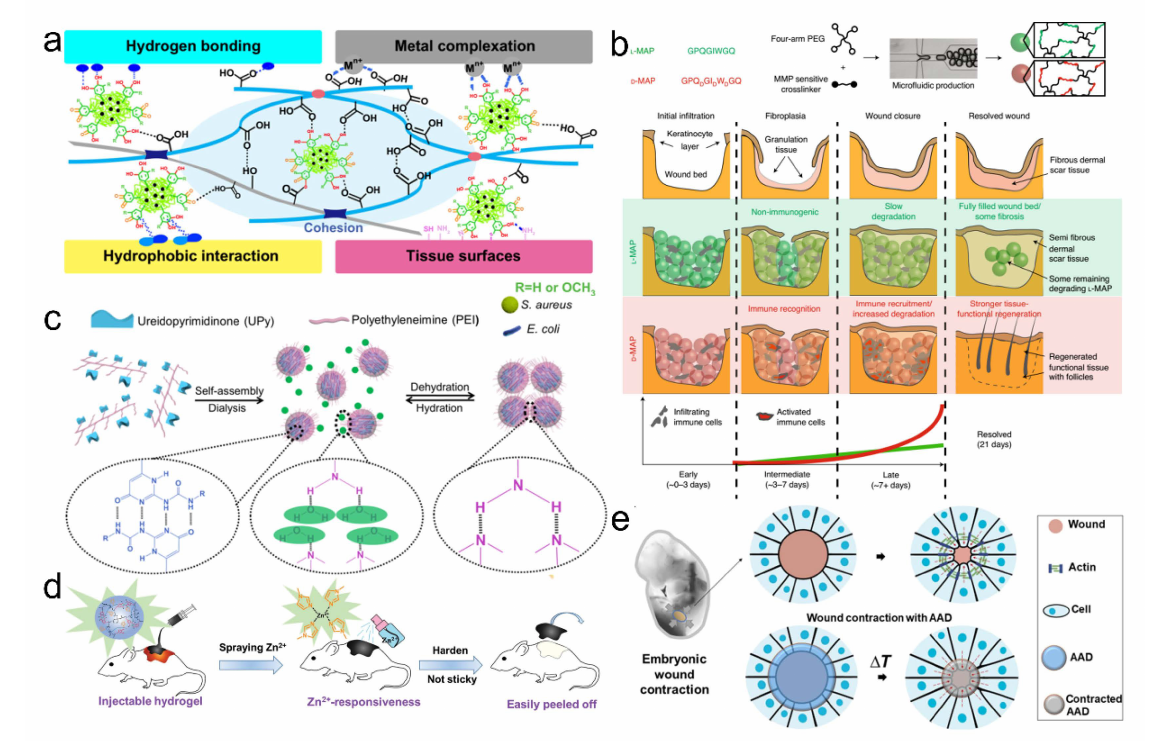
Figure 6. ( a ) The NPs-P-PAA hydrogel could attach to the skin wounds for disinfection and healing. ( b ) Representation of the matrix metalloprotease (MMP) cleavage sequences, amino acid chirality within the crosslinking peptides, and microfluidic formation of the micro-hydrogel that incorpo- rated L- or D-chirality peptides (top row). Compared with L-chirality hydrogel, the D-chirality hydrogel activated the adaptive immune system over time, which caused tissue remodeling and skin regeneration as the adaptive immune system degraded the D-chirality scaffold. Reproduced with permission [74]. Copyright 2021, Springer Nature. ( c ) A supramolecular adhesive through the assembly and aggregation of hydrogen-bonded UPy-PEI particulates demonstrated the strong adhesion ability on animal skins and sustained release of antimicrobial particulates for wound disin- fection. Reproduced with permission [75]. Copyright 2020, American Chemical Society. ( d ) Scheme illustration of the wound dressing change facilitated by spraying with zinc ions. Reproduced with permission [76]. Copyright 2020, Royal Society of Chemistry. ( e ) Skin wounds of the chicken embryo (left), in which an actin cable (green) is formed in the cells at the wound edges and contacts the wound. Active wound contraction was enabled by the dressing that adhered to and contracted the wound edges at the skin temperature. Red dashed arrows indicate the